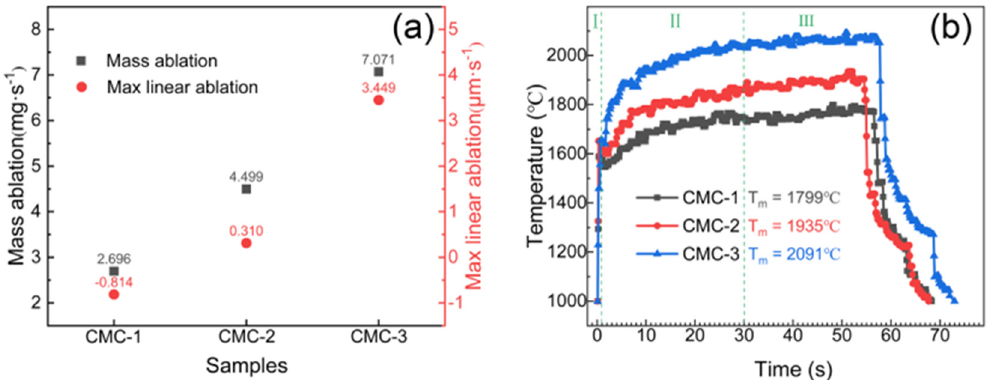
Figure 6. Ablation rates and surface temperature curves of C/C-SiC-(Zr x Hf 1 − x )C composites: ( a ) Ab- lation properties; ( b ) Surface temperature curves.